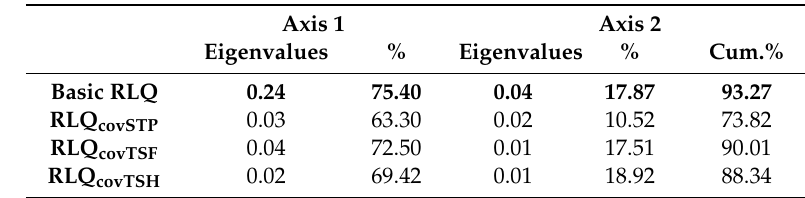
“RLQ covSTP ”, “RLQ covTSF ”, or “RLQ covTSH ” respectively mean partial RLQ analysis using stand type (STP), time since fire (TSF), or time since disturbance (TSH) as co-variable. The RLQ analysis with the highest cumulative percentage of variance is explained by the first two axes was in bold.